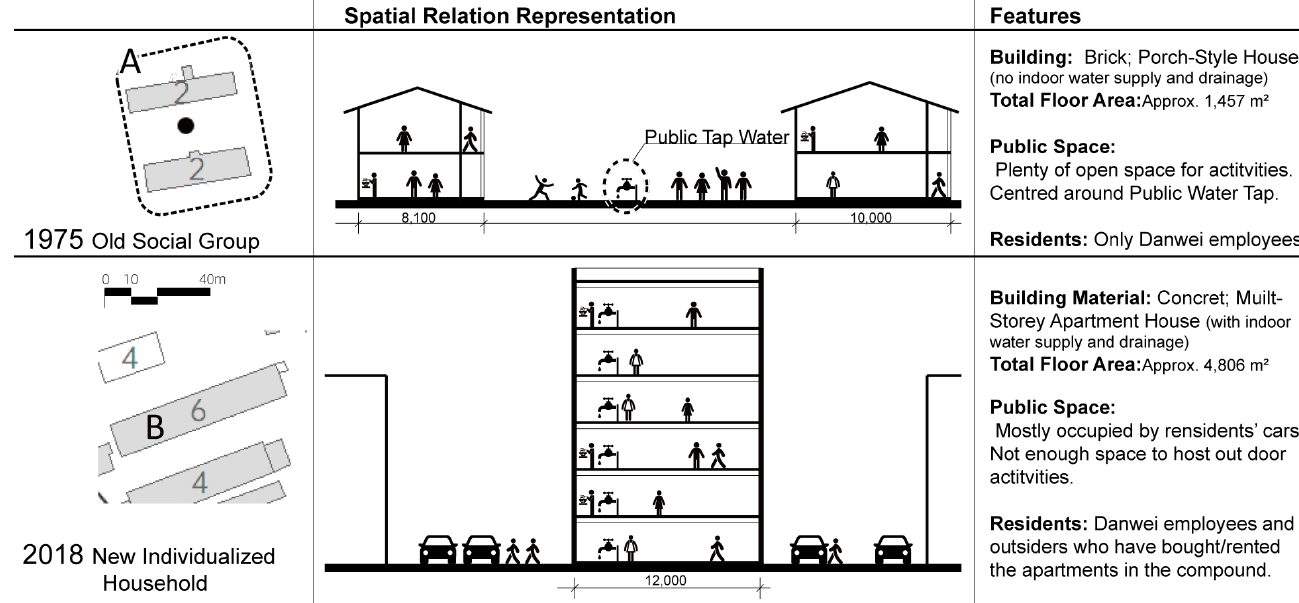
Figure 12. Public water supply, toilets and buildings of the AMS Danwei compound.